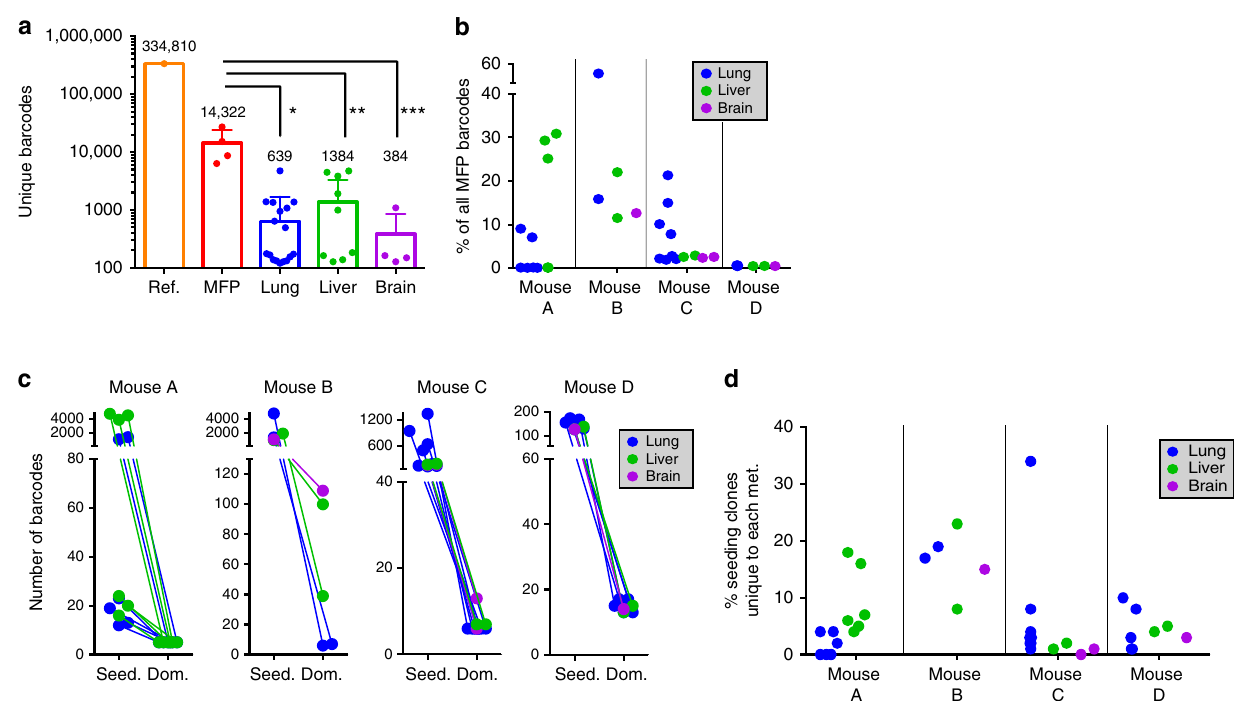
Fig. 5 Metastases harbor numerous low-abundance seeding clones. a Number of seeding clones, de fi ned as barcodes detected regardless of copy number, is plotted. Barcodes present in metastases were only counted if they were also detected in the corresponding MFP tumor. The mean number of barcodes in each sample is denoted above each bar. (two-tailed T -tests, * p = 2.65e − 7, ** p = 0.00025, *** p = 0.024; error bars are SEM; n = 4 MFP tumors, n = 21 lung, n = 12 liver, and n = 4 brain metastases). b The percent of seeding clones detected in each metastatic lesion relative to the total number of unique barcodes detected in its matched MFP tumor is shown. c The number of dominant barcodes in metastases of each organ was compared with the total number of seeding clones detected in each metastasis. d The percentage of seeding clones that are unique to each metastatic site (detected in the MFP tumor of that mouse, but not in any other metastasis of that mouse) is